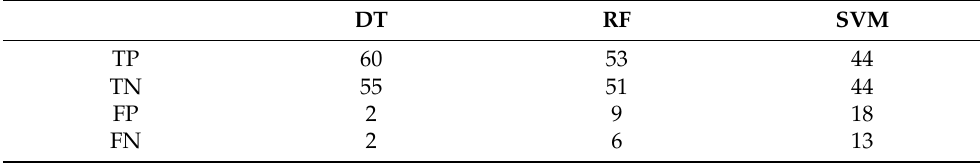
Table 3. Comparison of classifier performance using a confusion matrix.